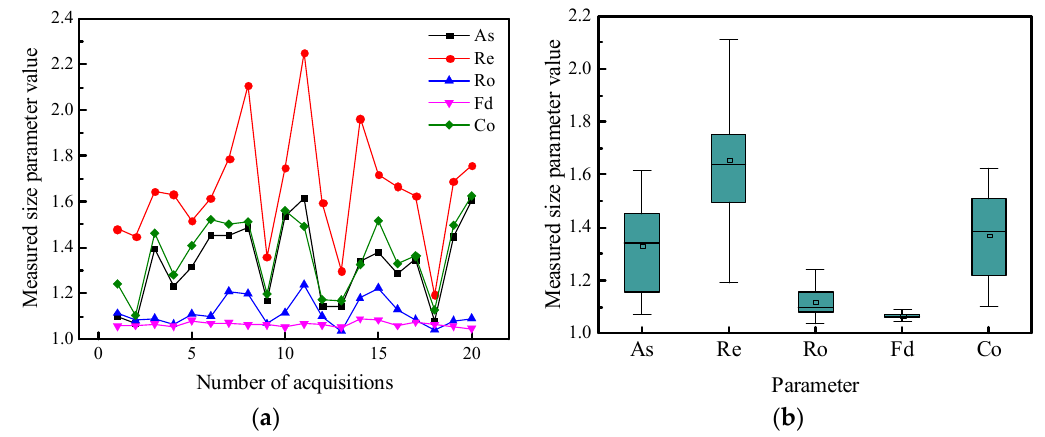
Figure 13. Variations in the parameters measured for the 20 projections of MSA: ( a ) changes in parameters about acquisition direction ( b ) and boxplot showing the variability of the size parameters.